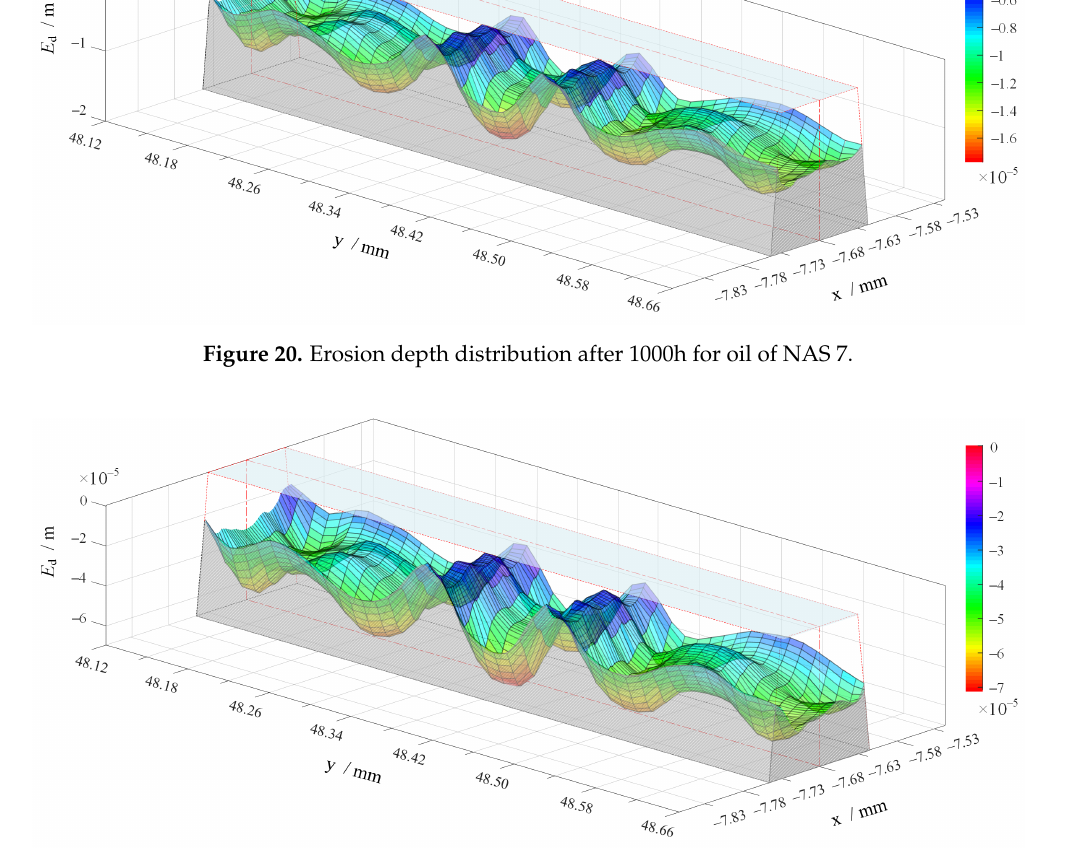
Figure 21. Erosion depth distribution after 1000h for oil of NAS 9.